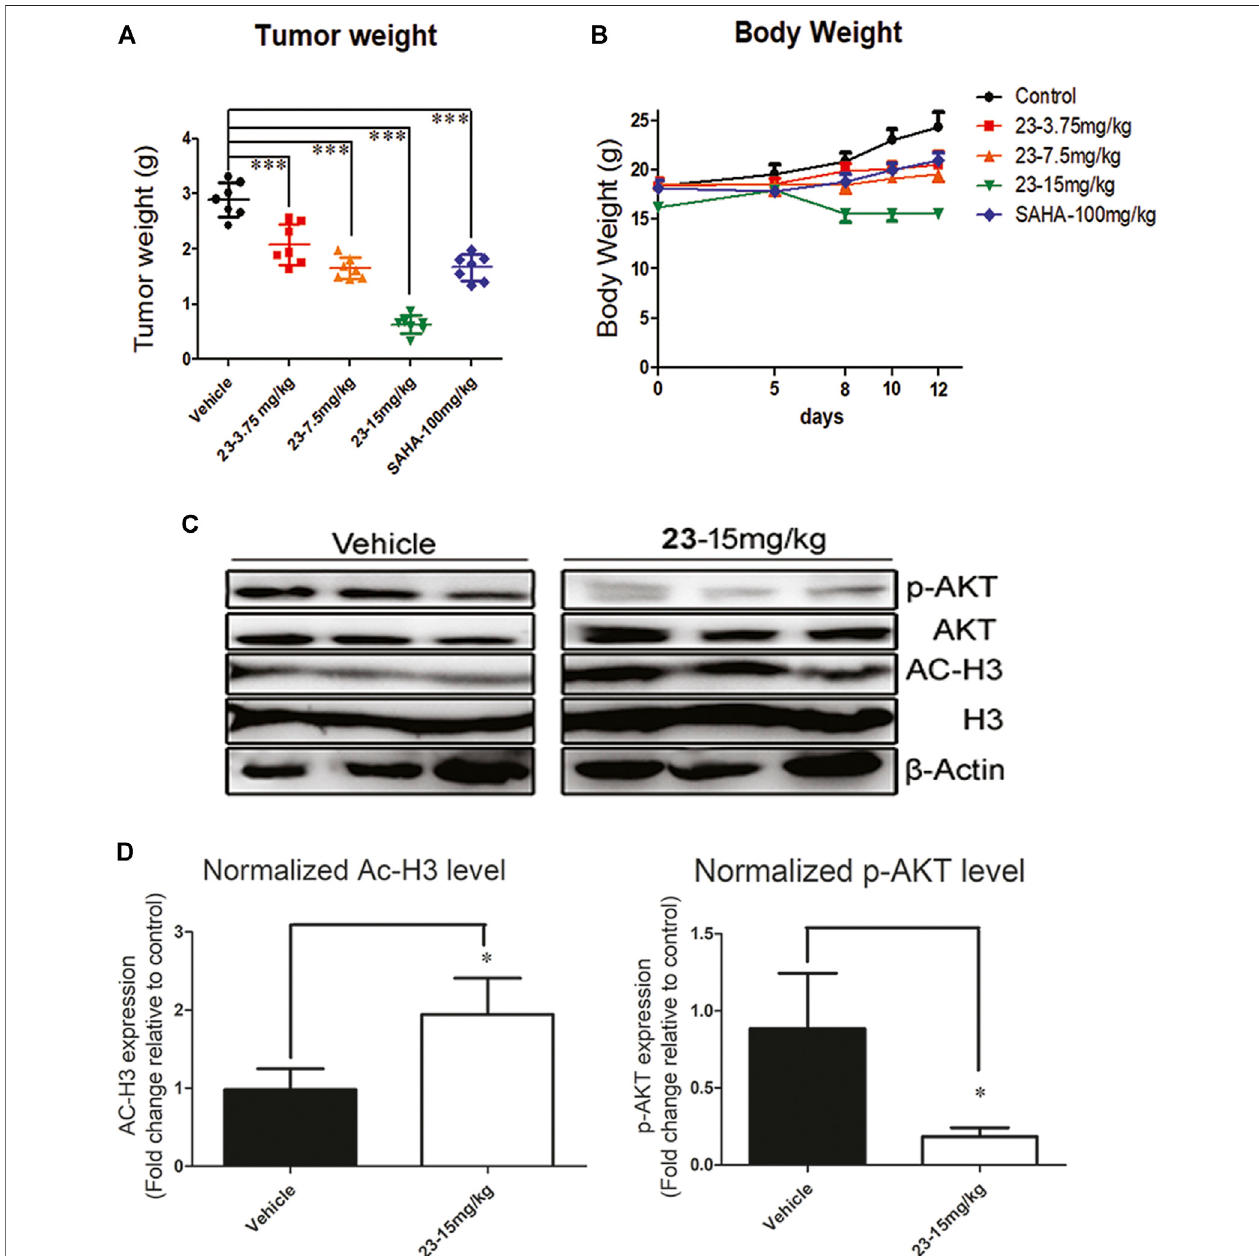
FIGURE 5 | An EL4 xenograft model was included to evaluate the antitumor activity of compound 23 against T lymphoma in vivo . (A) . Tumor weight after intraperitoneal administration of compound 23 at dosages of 3.75, 7.5 and 15mg/kg or oral administration of SAHA at dosage of 100mg/kg. (B) . Average body weight changes of compound 23 , SAHA , and vehicle groups during administration. (C) and (D) . The modulation on HDAC and AKT pathways in EL4 tissue in 15 mg/kg of compound 23 group and vehicle group (* p < 0.05, ** p < 0.01, *** p < 0.001 vs. Control).